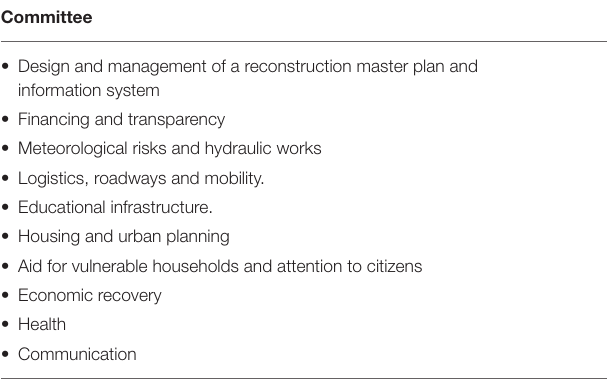
TABLE 3 | Committees of the Nuevo León State Reconstruction Council, after Hurricane Alex,